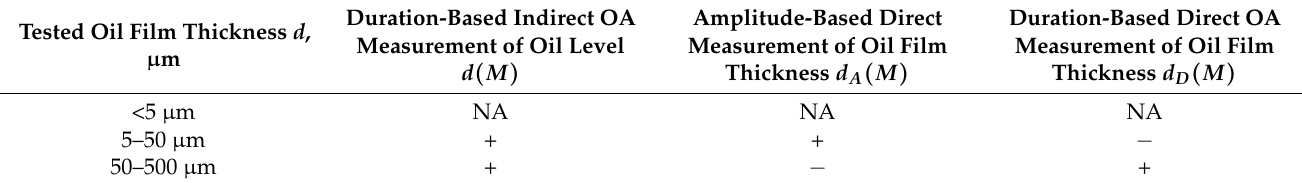
Table 2. The limits of applicability of OA methods of oil thickness